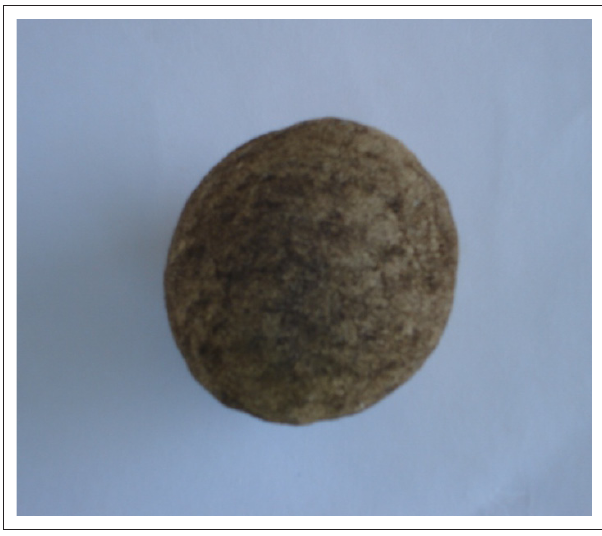
FIGURE 3: A trichobezoar (approximately 5 cm in diameter) removed from the abomasum of a calf. The structure and constituents are completely different from the rumenolith described. Hair is clearly palpable on the surface and there are no